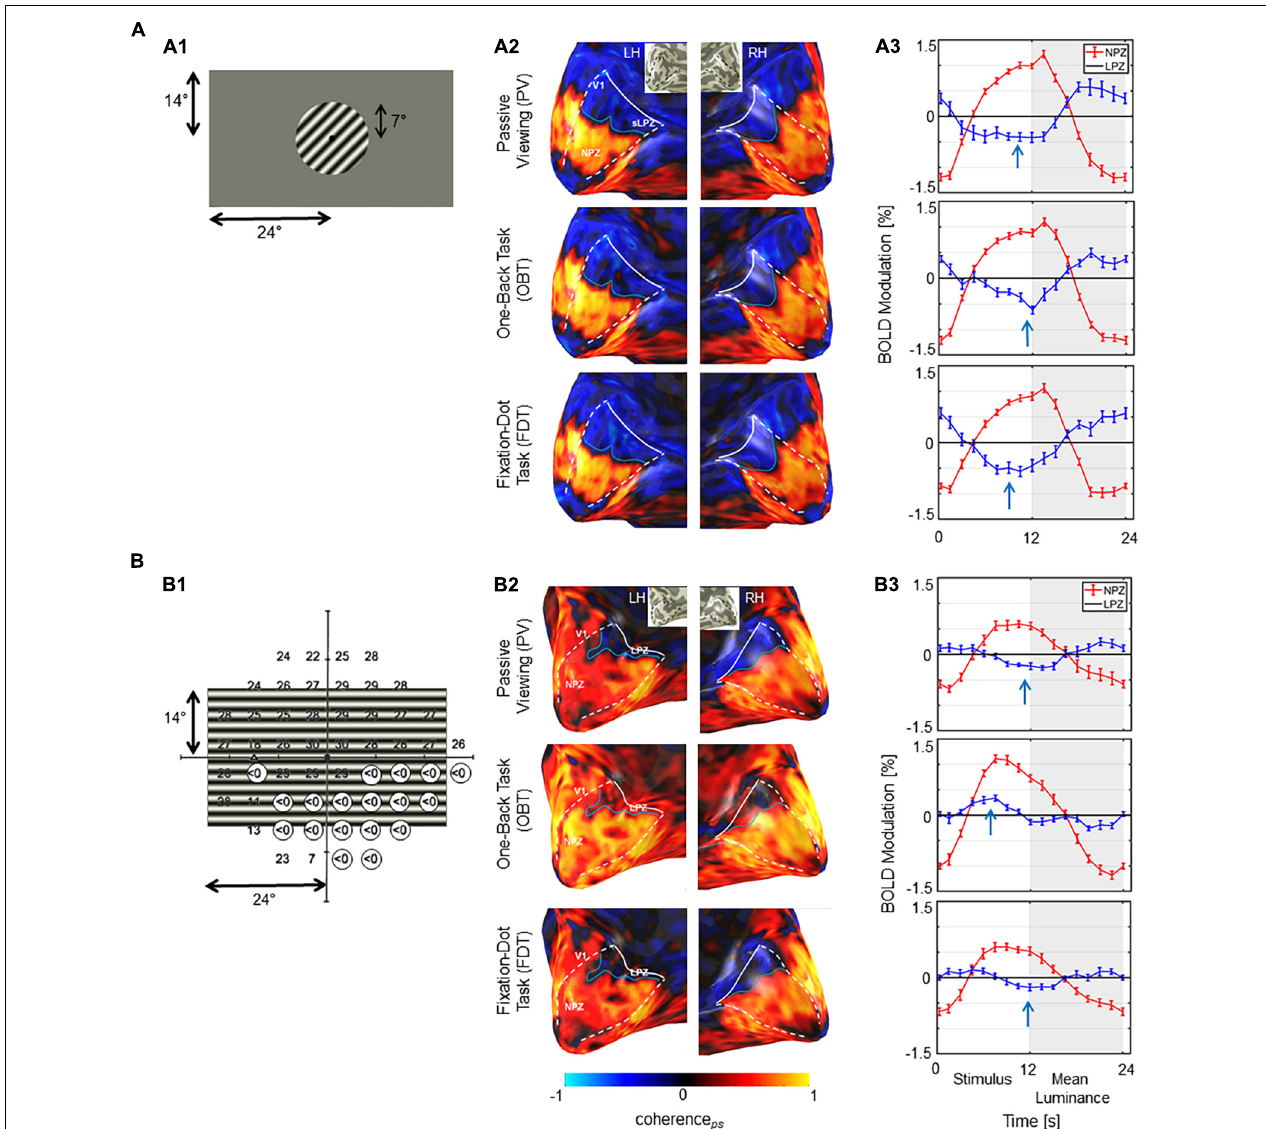
FIGURE 3 | Stimulus schematics and fMRI-based activations. (A) Control HC1 (A1) Illustration of stimulated visual field for the controls with the simulation of a scotoma by peripheral masking beyond 7 ◦ . (A2) BOLD-activations (coherence ps ) for the three task conditions projected onto the inflated occipital lobe as false-color overlays. V1 boundaries (white dashed) and the anterior extent (white solid line) were determined from the participants pRF mapping; NPZ and LPZ are indicated. (A3) Average single-cycle BOLD time series for the three conditions in the NPZ (red) and LPZ (blue) ROIs. White and gray zones indicate motion and blank blocks, respectively. The induced BOLD response is shifted due to the hemodynamic delay. Stimulus related BOLD modulations in LPZ are negative, irrespective of the task condition, as indicated by the arrows. (B) Glaucoma participant GL1. (B1) Visual field sensitivities for the study eye (left eye SAP) as determined perimetrically are superimposed onto stimulus layout (absolute scotomas are highlighted by white discs). (B2) BOLD-activations (coherence ps ) depicted as for A2. V1 was determined from the participants pRF mapping data informed by atlas mapping as detailed in section “Materials and Methods.”. (B3) Average single-cycle BOLD time series depicted as for A3. Depending on task, LPZ responses were negative (PV/FDT) or positive (OBT), as indicated by the arrows. NPZ, normal projection zone; LPZ, lesion projection zone; RH, right hemisphere; LH, left